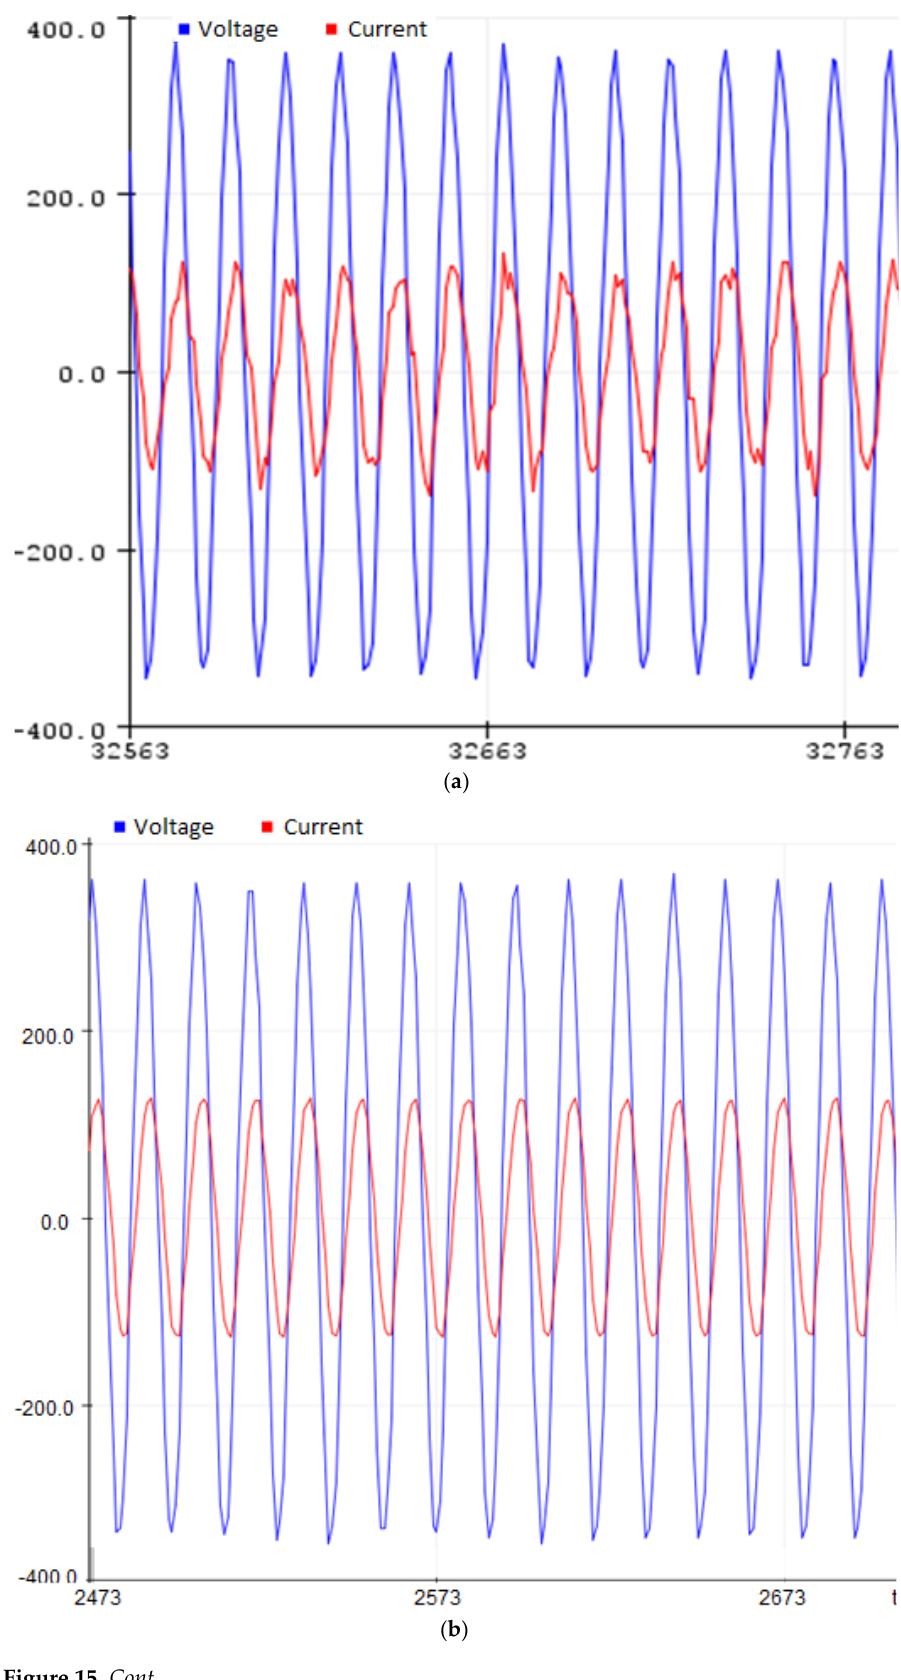
Figure 14. Hardware setups with three different loads: an ( a ) incandescent lamp, ( b ) electric iron box, and ( c ) laptop charger.